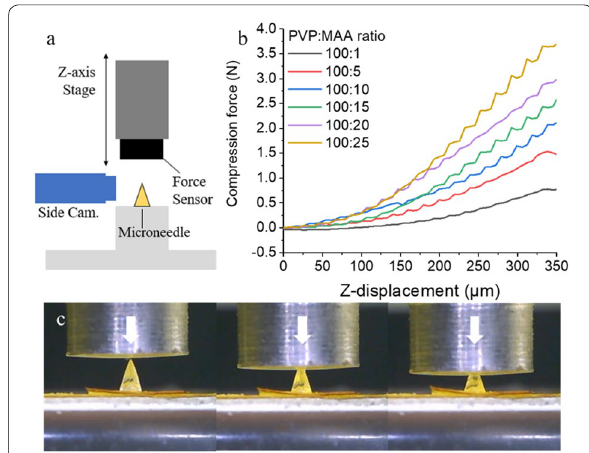
Fig. 4 The experiment setup ( a ) and reaction force ( b ) of the microneedle at different co‑polymer ratio. c Optical images of the compression